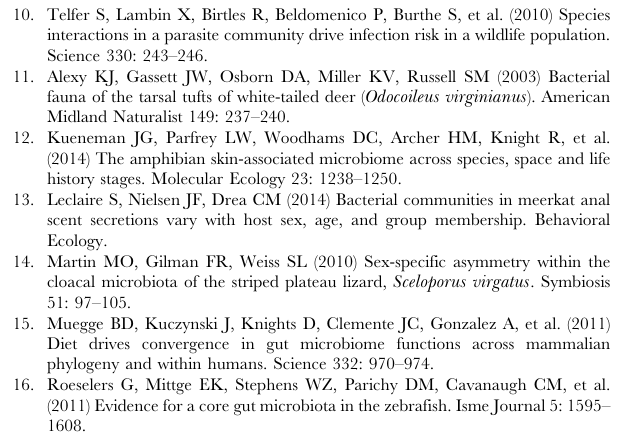
Figure S2, Non-metric multidimensional scaling (MDS) ordination of blood samples based on Bray-Curtis similarities in the presence/ absence data of the lineages in bacterial communities of rodent populations separates samples by host species. Each point represents the bacterial community in a given host species in a plot; Gerbillus andersoni individuals are indicated in green, G. pyramidum in purple and G. gerbillus in red. Point proximities represent the extent of similarity in bacterial community compositions. Oval shapes surround similar bacterial communities in host populations of the same species. Note that for an improved illustration, one outlier was omitted from the figure (bacterial community in one population of G. gerbillus ). Figure S3, Ranked bacterial lineage occupancy ( =prevalence) curves in the three types of rodent communities: single-rodent species (red), two- rodent species (light blue), and three rodent species (purple) communities. Best fitted curves are indicated by